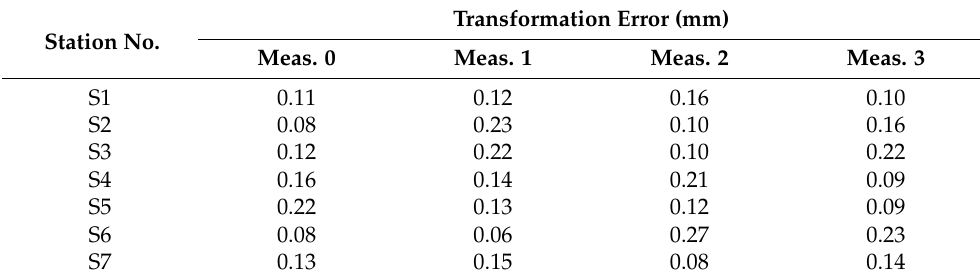
Table 5. Isometric transformation errors (mm). Station